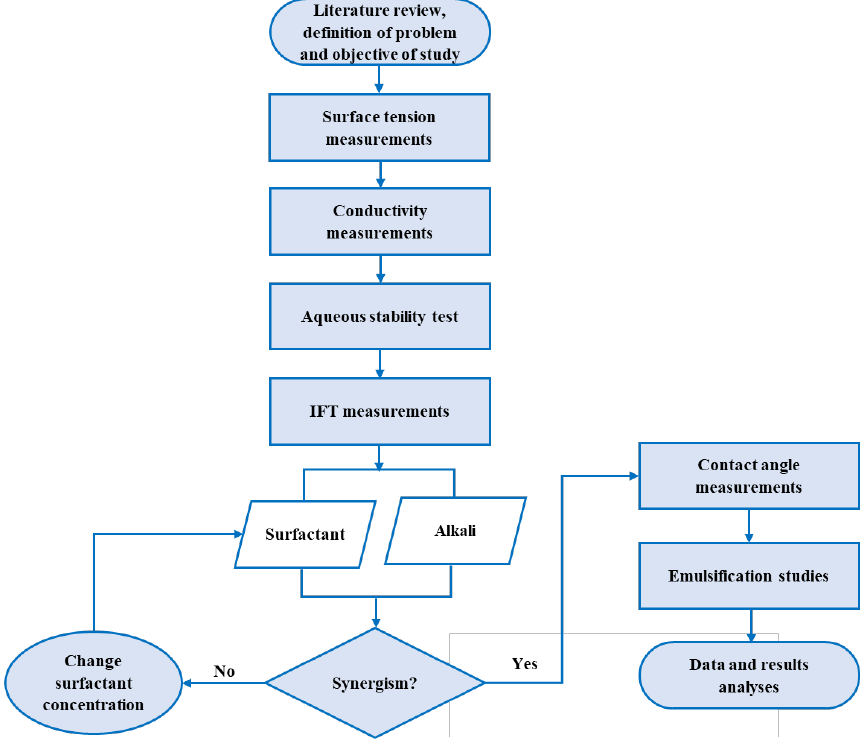
Figure 3. Flow chart of the experimental methods.